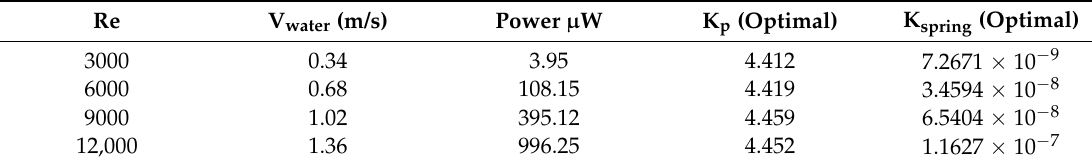
Table 4. Energy harvester power output for all water velocity cases for all cases and their corresponding optimal values of the spring constant K spring and proportional gain of the control law K p .